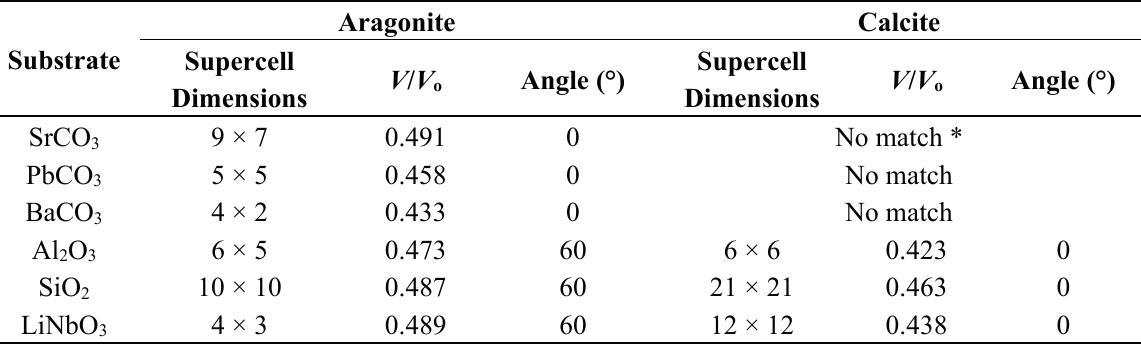
Table 2. The maximum size of supercell dimensions along with the azimuthal angles that generated the dimensionless potential ( V / V o ) less than 0.5, when the epitaxy relationships between the (0 0 1) planes of the various substrates and the overlayers (aragonite and calcite) were calculated.